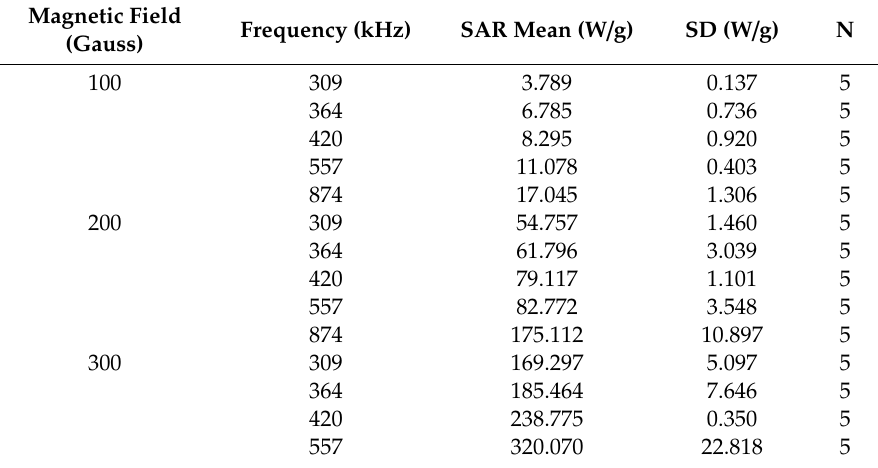
Table 2. SPIONa SAR values for di ff erent combinations of magnetic field (100, 200, and 300 Gauss) and oscillation frequencie (309, 364, 420, 557, and 874